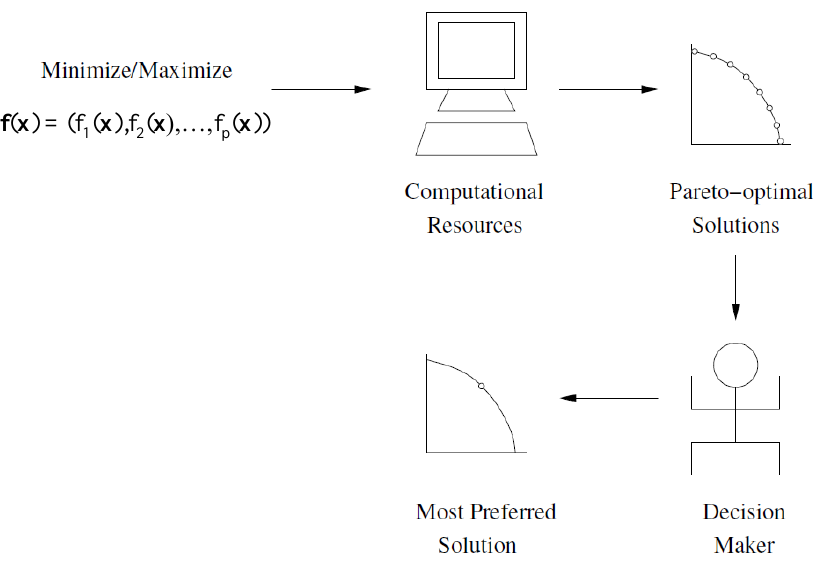
Figure 4. A posteriori